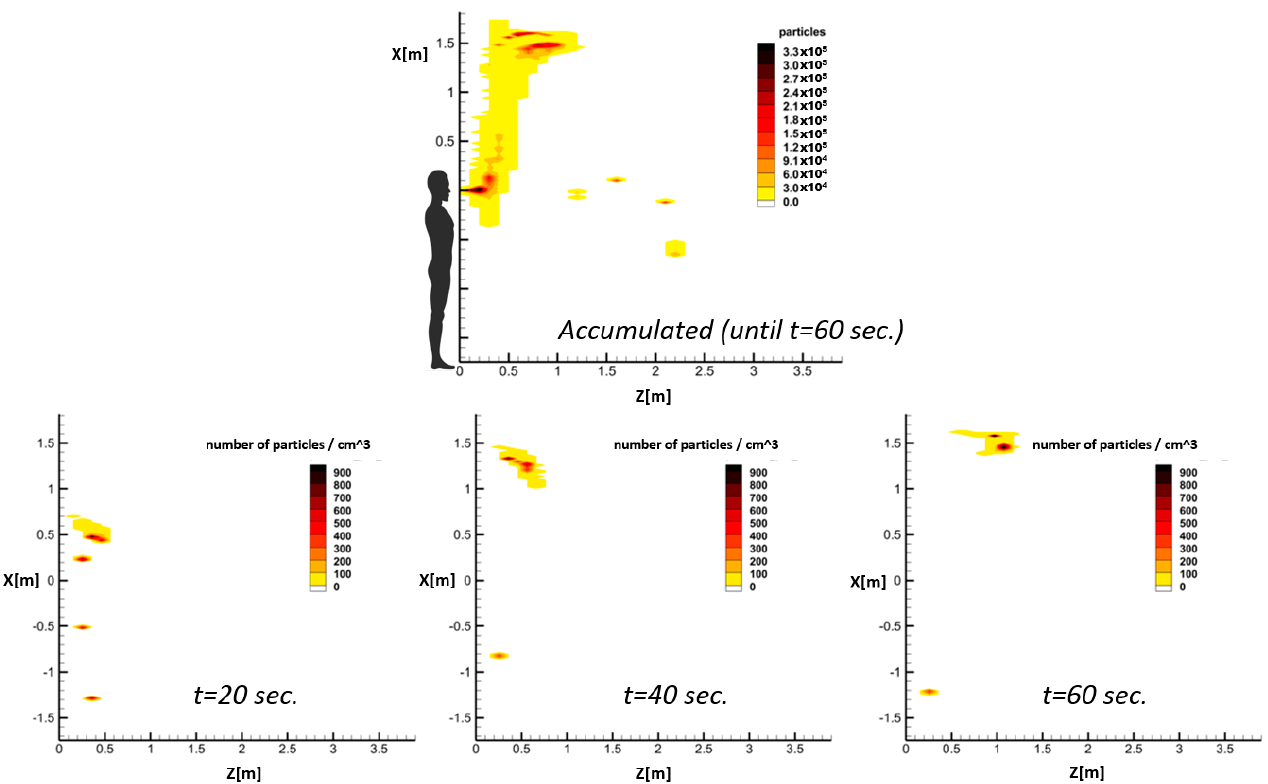
Figure 10. ( top ) The accumulated spread pattern until t = 60 s against ( bottom ) the time-resolved droplet concentration for a sneeze case at t = 20, 40, and 60 s (velocity = 50 m.s − 1 , temperature = 15 °C, RH = 50%).